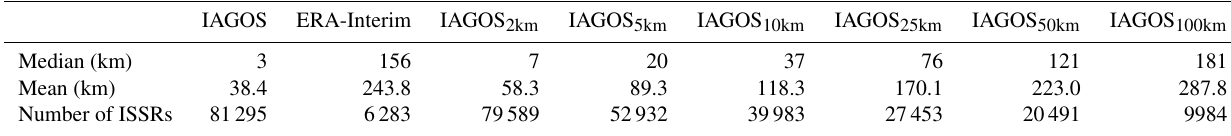
Figure 7. Time series of the monthly fraction of ice supersaturated regions for IAGOS (blue) and ERA (red) for the lower stratosphere (LS1 to LS3), the tropopause layer TL and the upper troposphere (UT1 to UT3). The dashed red line represents the ERA data set with the fraction of RH i ≥ 85% for the lower stratosphere, RH i ≥ 90% for the tropopause layer and RH i ≥ 95% for the upper troposphere. Note the different scale for the lower stratosphere. Table 5. Median and mean values and number of ISSR pathlengths for IAGOS, ERA-Interim and several running means of the original IAGOS data